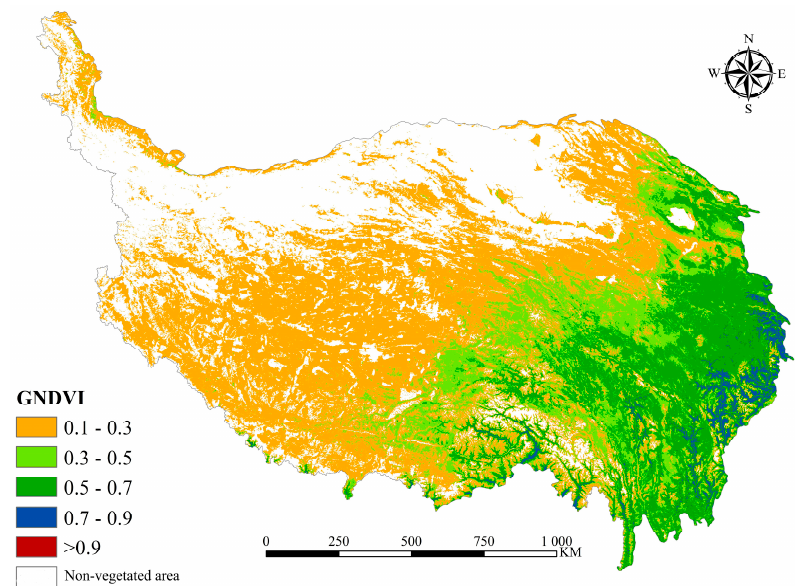
Figure 2. The spatial distribution of 20-year mean GNDVI on the QTP during 2000–2019.